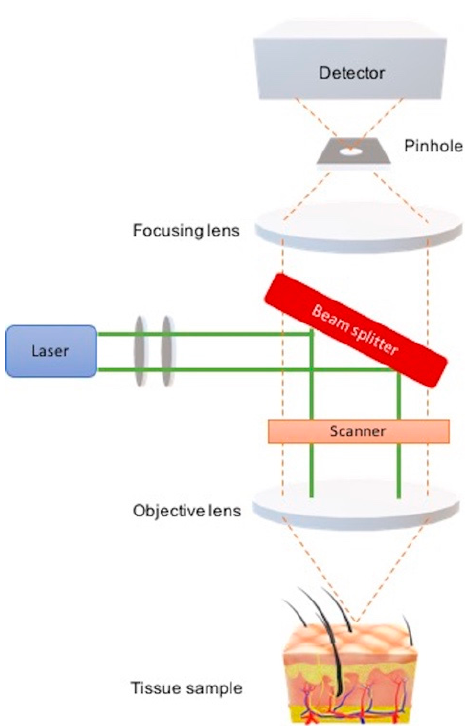
Figure 1. Schematic representation of optical principles of confocal laser scanning microscopy.